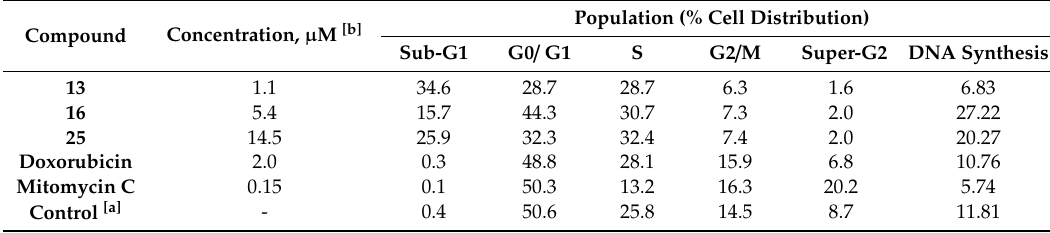
Table 4. Cell cycle analysis in DU-145 cell